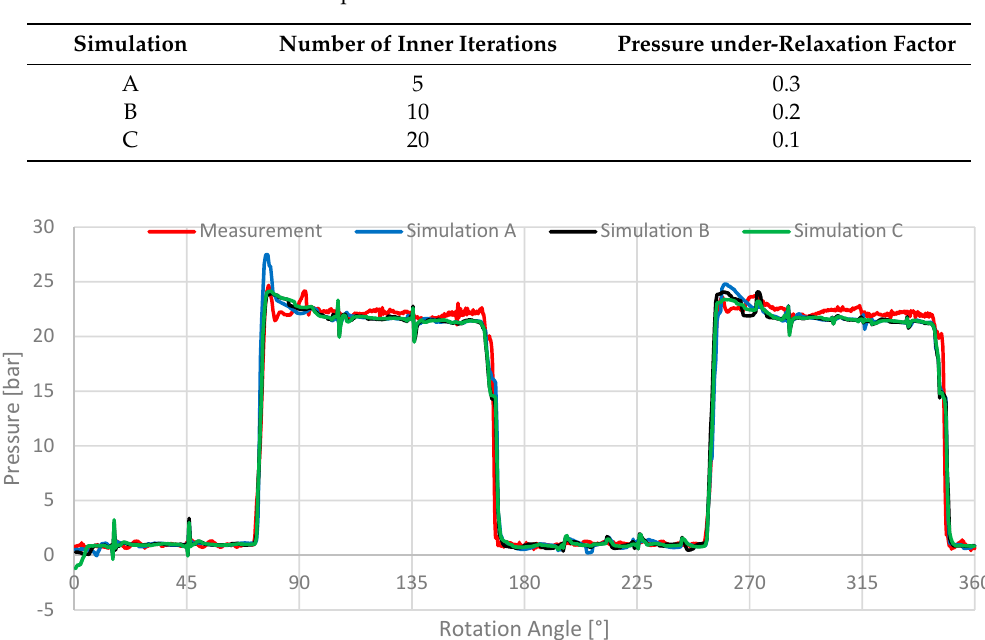
Table 3. Simulation parameters for different numbers of inner iterations.